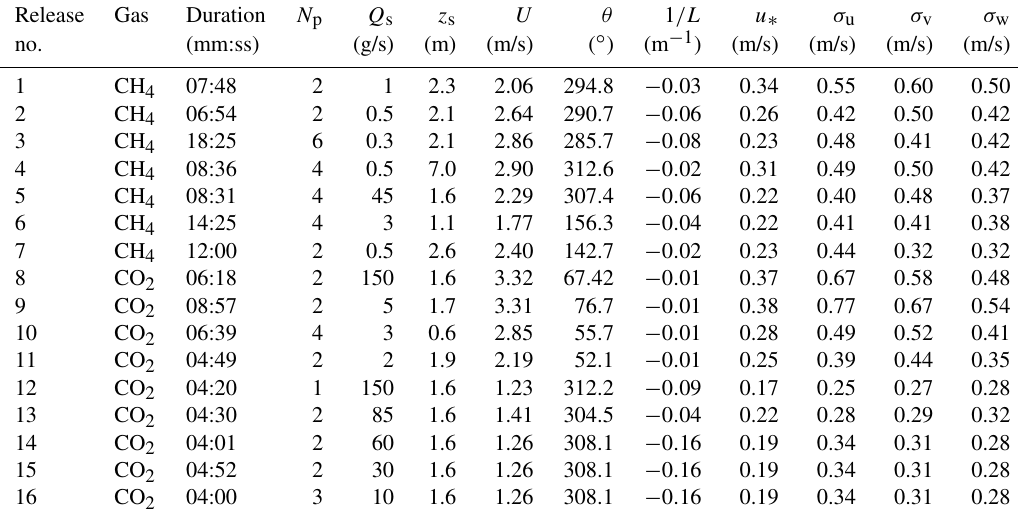
Table 2. Releases to which the inversion is applied, with the corresponding release duration, actual release rate ( Q s ), number of peaks ( N p ) in the mobile measurement transects, and averaged values of the meteorological and turbulence parameters (mean horizontal wind speed ( U ) and direction ( θ ), the Obukhov length ( L ), surface friction velocity ( u ∗ ), and standard deviation of wind velocity fluctuations ( σ u ,σ v , and σ w ) ) over the release period.